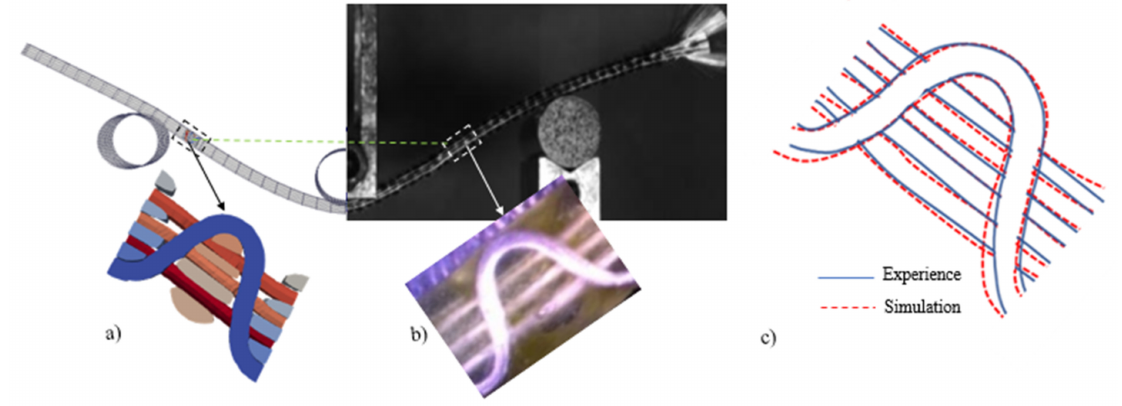
Figure 9. Deformed geometry of RVE in the same position obtained by: ( a ) simulation, ( b ) experiment, and ( c ) comparison of the outlines of binder yarns and warp